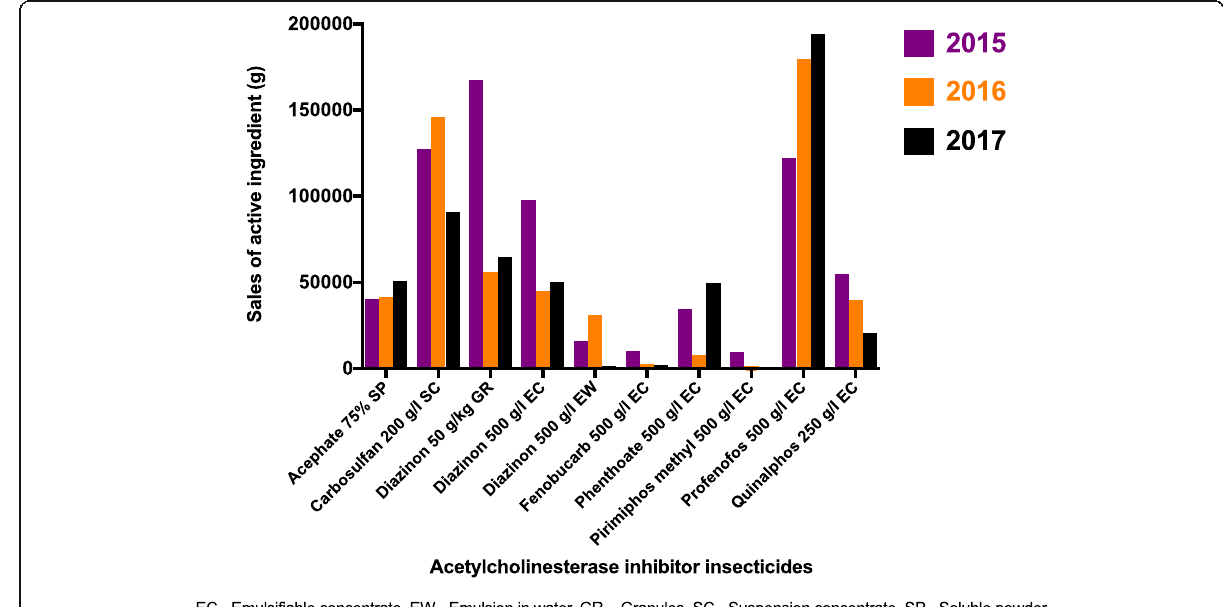
Fig. 4 Sales of acetylcholinesterase inhibitor insecticides by active ingredient, AChEII study, Anuradhapura,